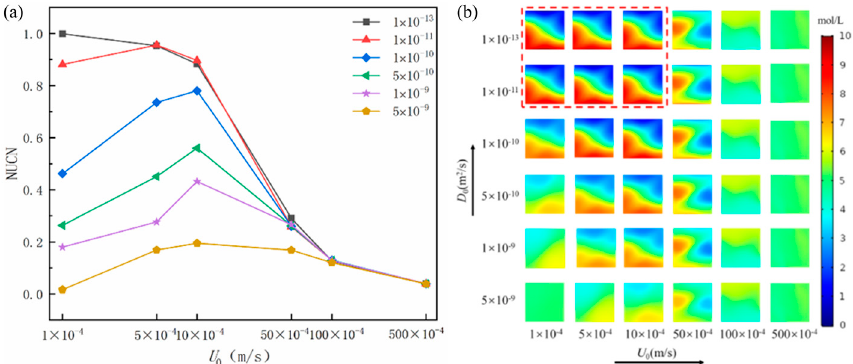
Figure 10. The influence of inlet velocity on mixing effect: ( a ) NUCN value corresponding to the concentration distribution nephogram of the outlet section of chaotic Baker mixer; ( b ) nephogram of concentration distribution at the outlet section of chaotic Baker mixer under thirty-six working conditions.